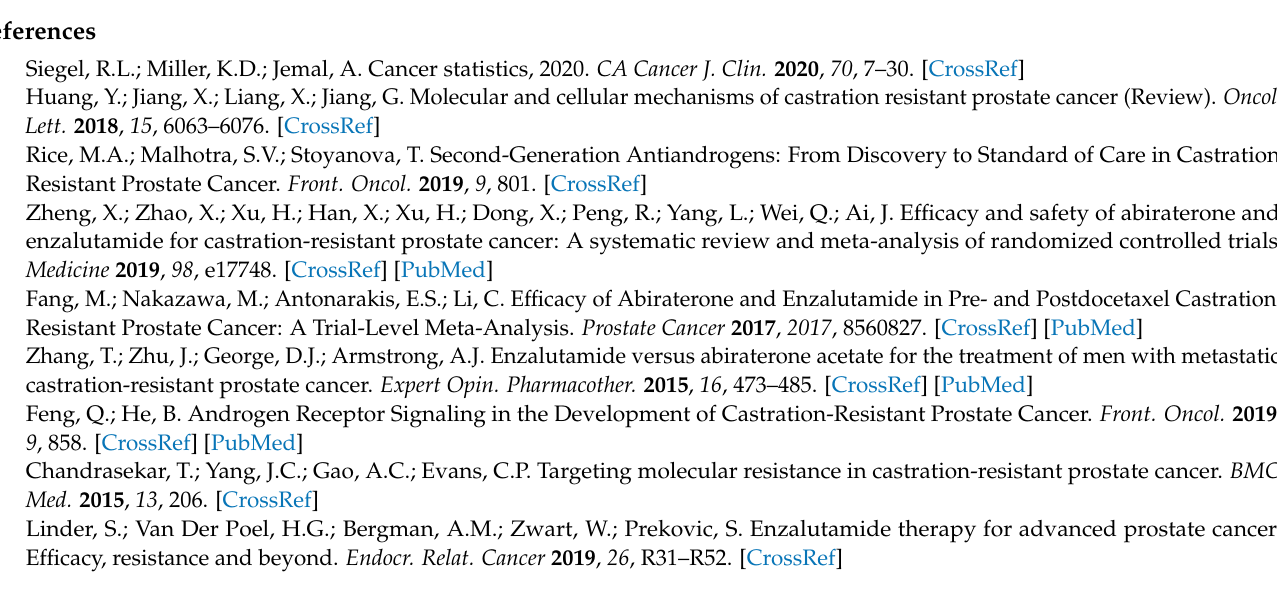
Figure S2: IC50 values and Combination Index for metformin, Abi and Enz, Figure S3: ( A ). Cell cycle analysis. Cells were trypsinized, washed with PBS twice and fixed in ice-cold 70% ethanol for 60 min, centrifuged and resuspended in 50 g/ml propidium iodide (PI). A BD FACSCanto-II Flow Cytometer was used to detect the different cell cycle phases, and data analyzed with FCS Express 7 and plotted using GraphPad Prism (v.8) software. ( B ). Data summary of A. Results are the mean of two independent experiments, each consisting of three replications, * ( p < 0.05), student’s t -test, Figure S4: 2-D clonogenic assay for LNCaP (left) and VCaP cells (right). The plated cells were treated with abiraterone (Abi) 5 µ M, enzalutamide (Enz) 10 µ M, and metformin (Met) 1 mM for over a week, then fixed with ethanol and stained with 0.5% crystal violet. ImageJ (1.48v) software was used to determine the area covered by the colonies and graphed with Excel program. Results student’s t -test, Figure S5: Western blot. AR and PSA expression, Figure S6: Original western blots for Figure 1E,G, Figure S7: Original western blots for Figure 2E,F,H, Figure S8: Original western blots for Figure 3C,E,G,H,L, Figure S9: Original western blots for Figure 4C–F, Figure S10: Original western blots for Figure S5, Table S1: IC50 values of LNCaP